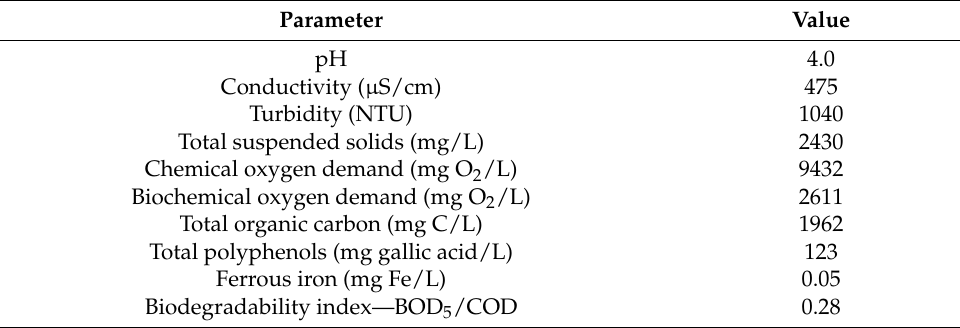
Table 1. Winery wastewater